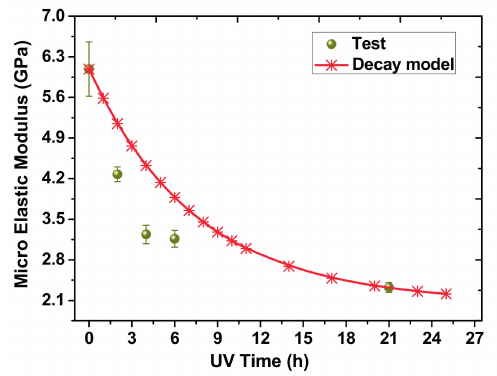
Figure 4. Microscale E of PI films at different UV irradiation times.